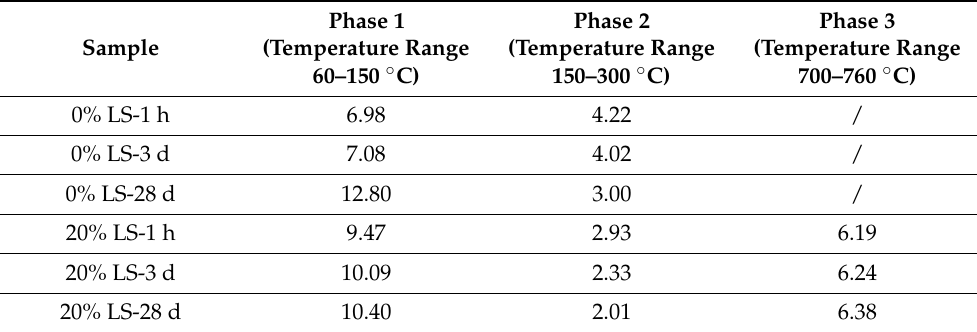
Table 1. The mass loss (%) for main decomposition phases of MAPC mortar samples with 0% and 20% limestone fines at different curing ages of 1 h, 3 days, and 28 days according to thermogravimetric (TGA)